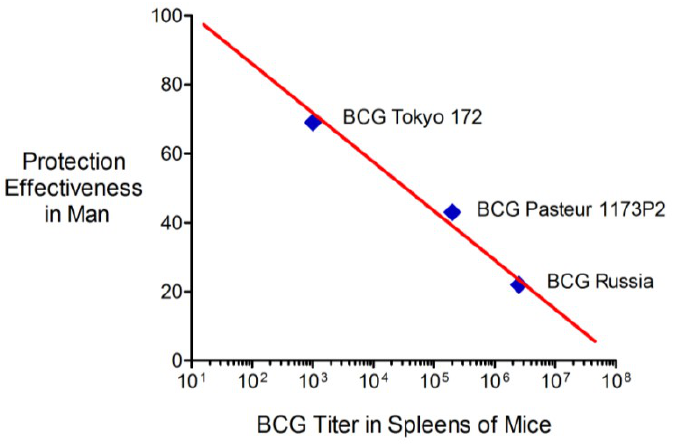
Figure 8. Inverse correlation between protection effectiveness in man and spleen titer in mice of three BCG daughter strains. The protection effectiveness values were taken from a cohort study in Kazakhstan [80] and involved BCG Russia (Microgen), Pasteur 1173P2 (Serbian ―Torlak‖ vaccine), and BCG Tokyo 172 (Japan BCG Laboratory). The log10 spleen titer values were taken from a comparison of 5 BCG strains in Balb/C mice [37] and represent the values at 12 weeks after intravenous inoculation of mice with 10 6 cfu of the vaccine